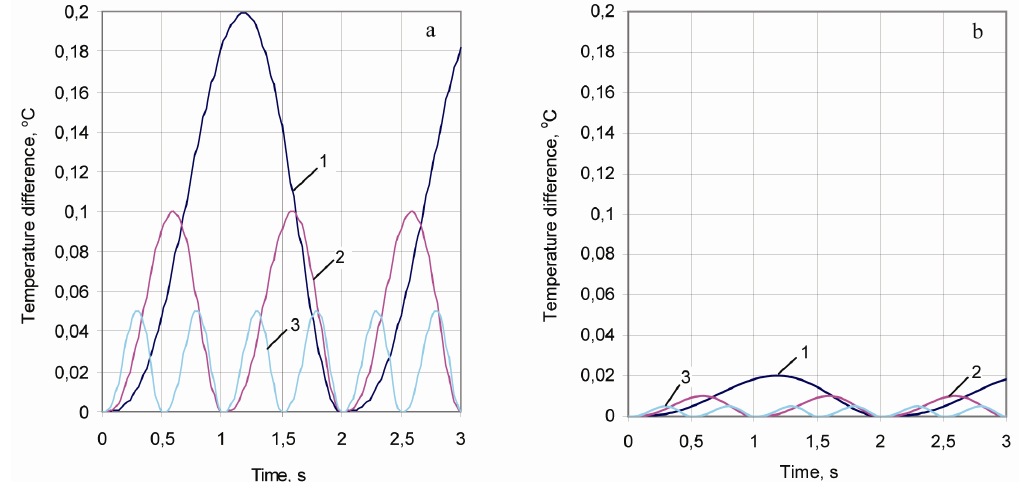
Fig. 7. The dependence of temperature pulsations in plant leaf plates of different thickness on the frequency of plant leaf oscillation when leaf oscillation amplitude β A = 60° in a − leaf plate part whose thickness is 0.1 mm; in b − leaf plate part whose thickness is